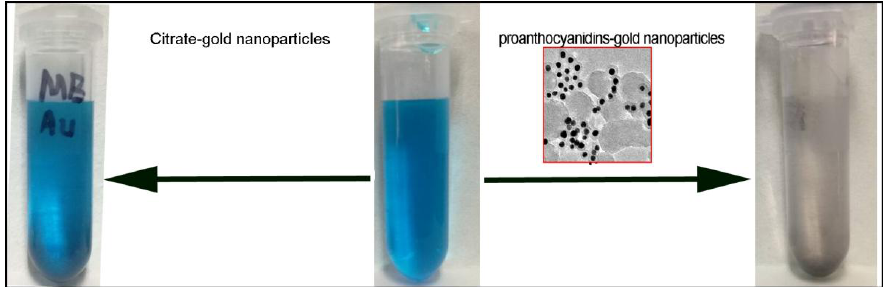
Figure 6. Photograph of the methylene blue (MB) solution (20 mg/L) before addition of gold nanoparticles and after addition of gold nanoparticles for 30 min.